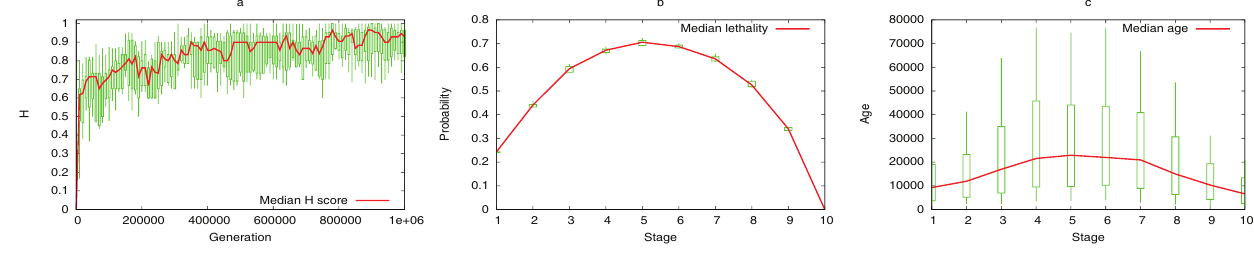
Figure 7. Computational results with Model-3. Parameters: 10 runs with different initial populations, N = 10 individuals, L = 10 stages, specificity function s ( l ) = l / L ( l = 1 . . . L − 1), Γ = 100 genes at each stage initially, RF parameter z = 4, 1,000,000 generations, probability of RW event P = 10 −4 . The probability of gene duplication P is adjusted dynamically so that the average DGEN size stays between 700 and RW DP 800 genes. The red line is the median and the green boxes are the 10th, 25th, 75th, and 90th percentiles, across all individuals and all runs. The hourglass score H across evolutionary time. ( b ) Lethality probability at each stage. ( c ) Age of existing genes at the last